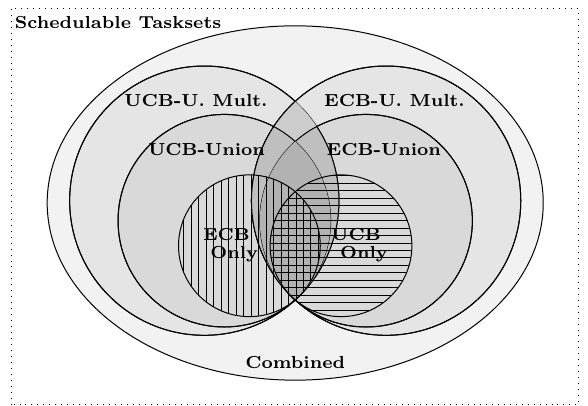
Figure 2 Venn diagram showing the relationship between different approaches for CPRD analysis under FP